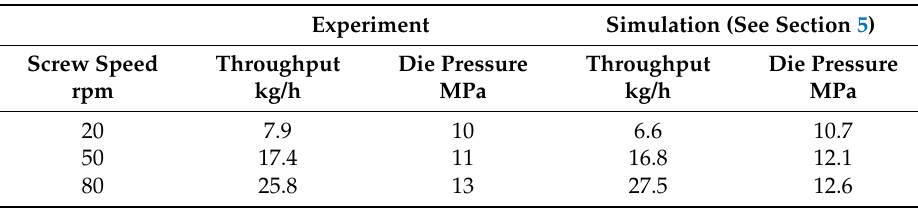
Table 3. Predicted versus measured process parameters.